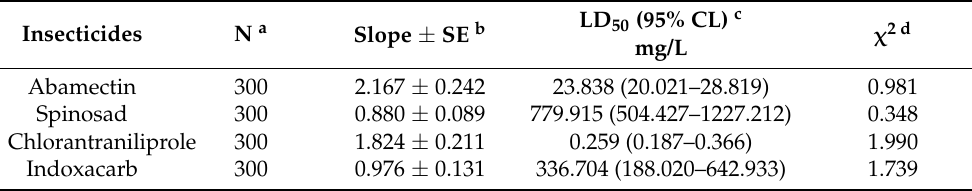
Table 4. Toxicity of four insecticides to third-instar larvae of T. absoluta . Insecticides N a Slope ± SE